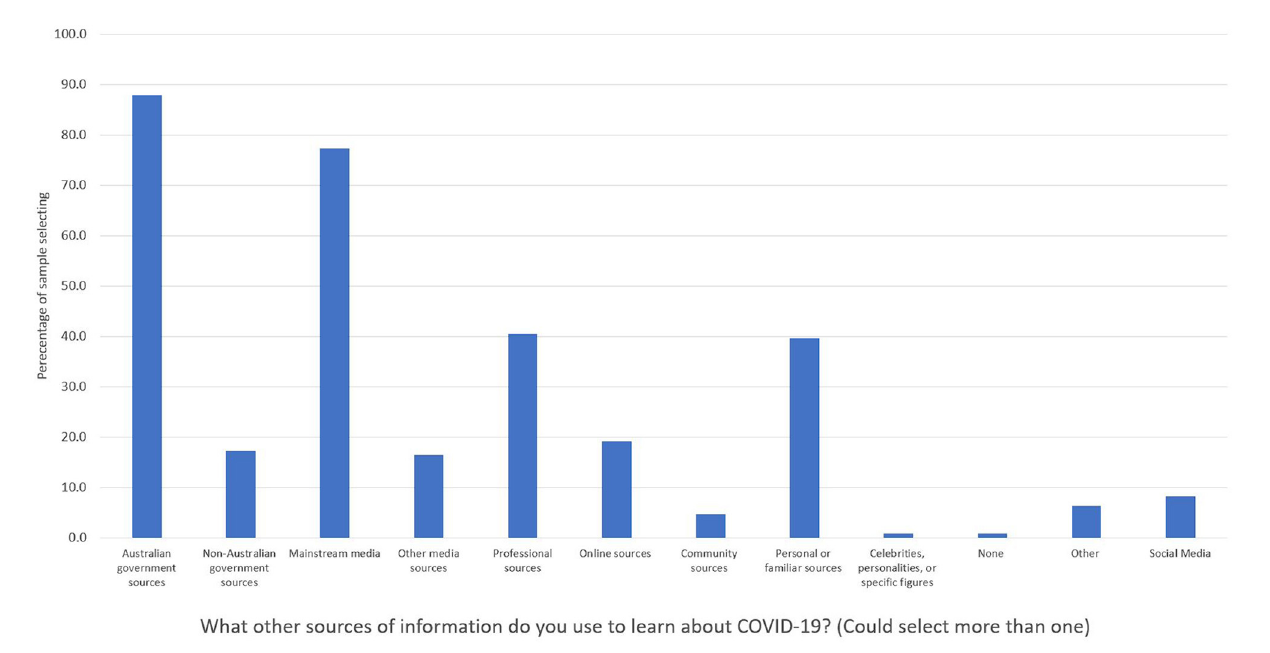
FIGURE1 Percentage of people selecting (vs. not selecting) information sources used to learn about COVID-19. Participants ( n = 255) could select multiple options.